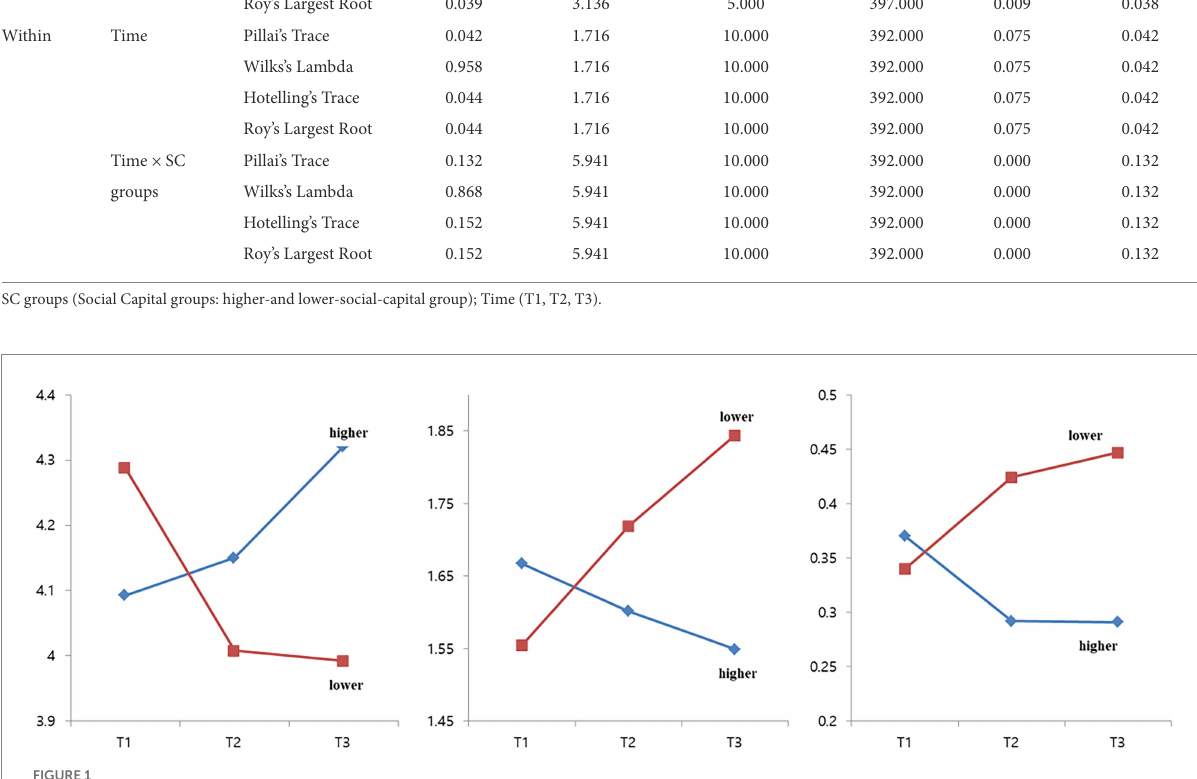
FIGURE 1 Change of life satisfaction (left), depression (middle), loneliness